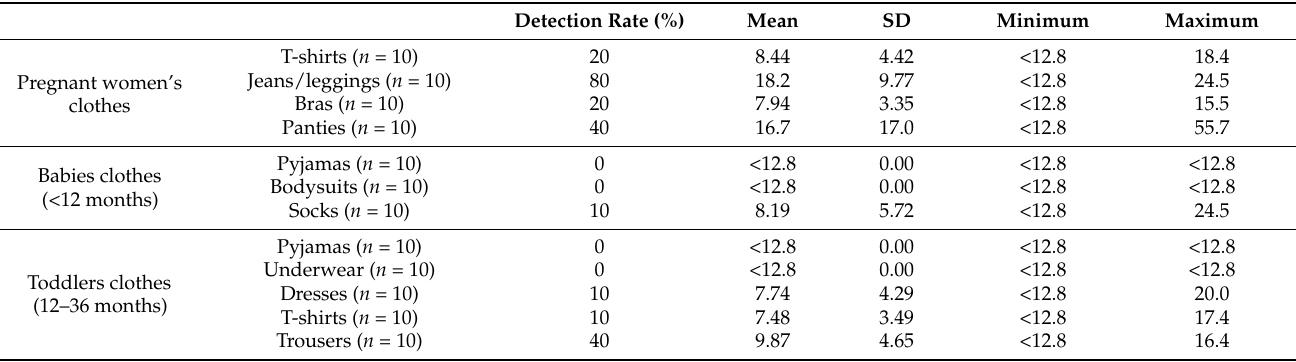
Table 3. Free and extractable formaldehyde levels (mg/kg) in the clothing of pregnant women, babies and toddlers purchased from Catalonia